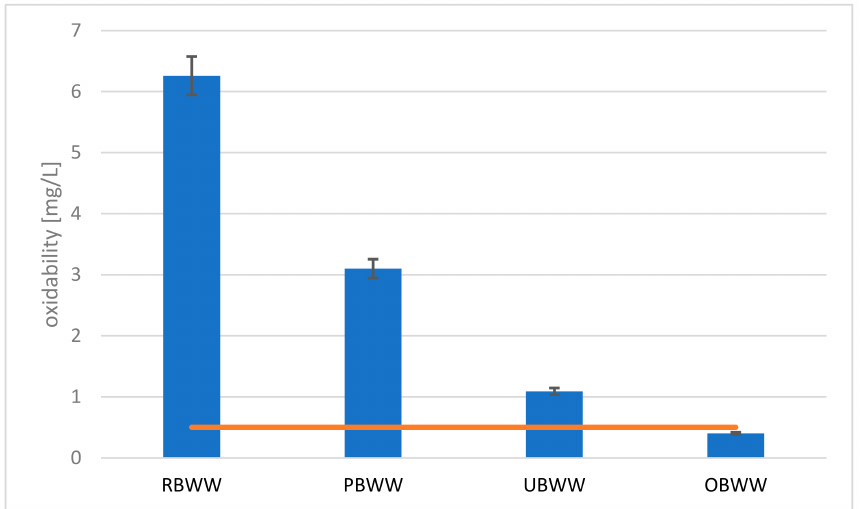
Figure 5. Changes in oxidability at individual stages of treatment: raw backwash water (RBWW), pre-filter backwash water (PBWW), ultrafiltration backwash water (UBWW), ozonation backwash water (OBWW).